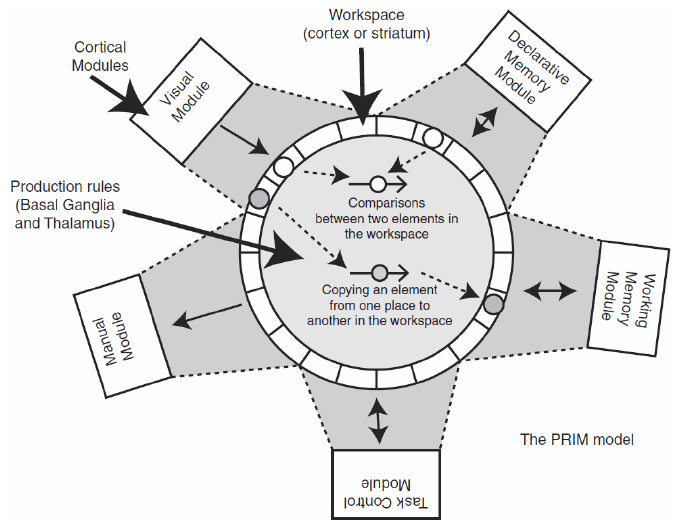
Figure 5. The PRIMs cognitive architecture, from [29]. Reprinted with permission from the author. In our work, PRIMs models of strategic reasoning can be used as “virtual participants” that play centipede-like